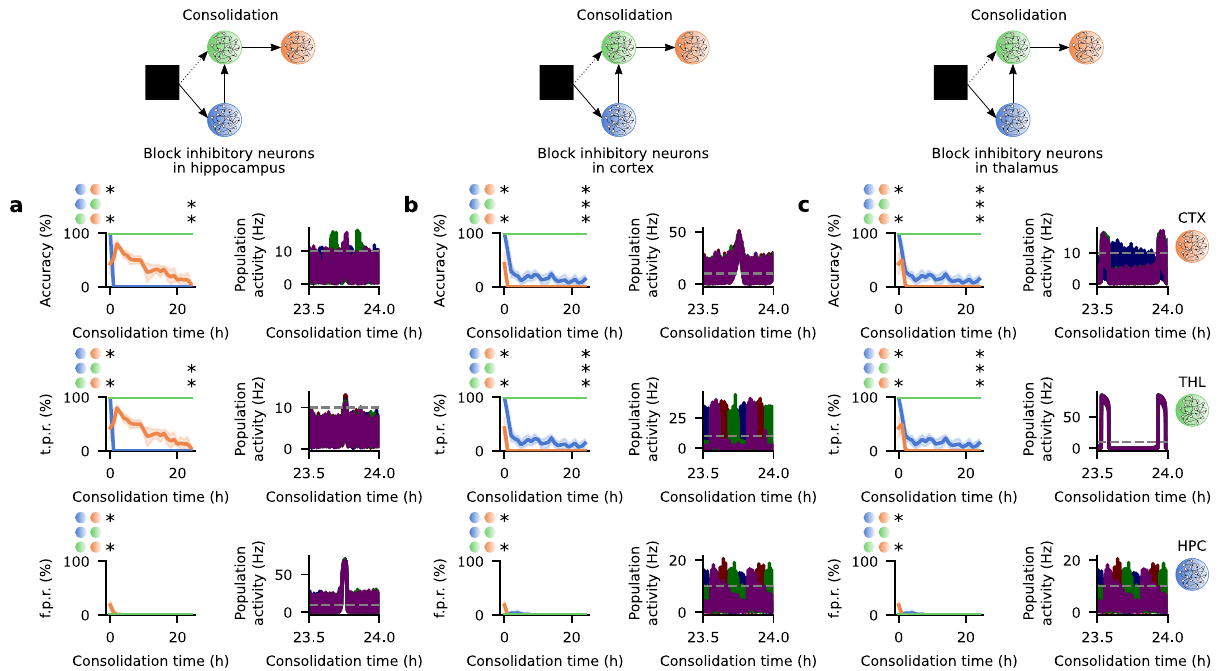
Fig. 4 Inhibitory input is critical for cortical engram maturation. a Memory recall as a function of consolidation time (left) and population activity of excitatory engram cells in the consolidation phase (right) when inhibitory neurons in HPC are blocked in the consolidation phase of the protocol in Fig. 2b. Recall curves (top to bottom): accuracy, true positive rate, and false positive rate ( n = 5 trials, mean values and 90% con fi dence intervals shown). For each recall metric, two-sided Mann – Whitney U test. Accuracy: consolidation time = 0 (HPC vs. CTX p -value = 7.494958×10 − 3 ; HPC vs. THL p -value = 0.920340; THL vs. CTX p -value = 7.494958×10 − 3 ) and 24h (HPC vs. CTX p -value = 0.177016; HPC vs. THL p -value = 3.976752×10 − 3 ; THL vs. CTX p -value = 6.501702× 10 − 3 ). True positive rate: consolidation time = 0 (HPC vs. CTX p -value = 7.494958×10 − 3 ; HPC vs. THL p -value = 0.920340; THL vs. CTX p -value = 7.494958×10 − 3 ) and 24h (HPC vs. CTX p -value = 0.177016; HPC vs. THL p -value = 3.976752×10 − 3 ; THL vs. CTX p -value = 6.501702×10 − 3 ). False positive rate: consolidation time = 0 (HPC vs. CTX p -value = 7.290358×10 − 3 ; HPC vs. THL p -value = 0.920340; THL vs. CTX p - value = 7.290358×10 − 3 ) and 24h (HPC vs. CTX p -value = 0.920340; HPC vs. THL p -value = 0.920340; THL vs. CTX p -value = 0.920340). Population activity of excitatory engram cells (top to bottom): CTX, THL, and HPC (each color designates the engram cells encoding the respective stimulus in Fig. 2a; dashed line indicates threshold ζ thr = 10Hz for engram cell activation). b Same as ( a ) but with inhibitory neurons in CTX blocked during consolidation (recall curves: n = 5 trials, mean values and 90% con fi dence intervals shown). For each recall metric, two-sided Mann – Whitney U test. Accuracy: consolidation time = 0 (HPC vs. CTX p -value = 7.494958×10 − 3 ; HPC vs. THL p -value = 0.920340; THL vs. CTX p -value = 7.494958×10 − 3 ) and 24h (HPC vs. CTX p - value = 2.536986×10 − 2 ; HPC vs. THL p -value = 7.494958×10 − 3 ; THL vs. CTX p -value = 3.976752×10 − 3 ). True positive rate: consolidation time = 0 (HPC